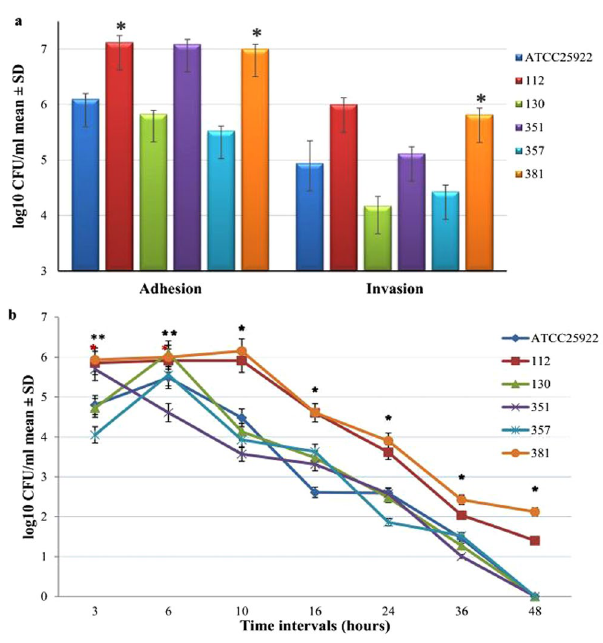
Figure 3. In vitro virulence assay of five E. coli isolates along with ATCC 25922 in macrophage RAW 264.7 cells. ( a ) Number of adherent and internalized bacteria. The results are presented as log10 of the mean ± standard deviation (SD) CFU/mL of three independent repeats and compared to E. coli ATCC 25922. ( b ) Intracellular survival rate of E. coli isolates at different time intervals. The results are presented as log10 CFU/mL mean ± SD of survival rate. Asterisk ( * ) represents statistical significance (P ≤ 0.05) using two-tailed